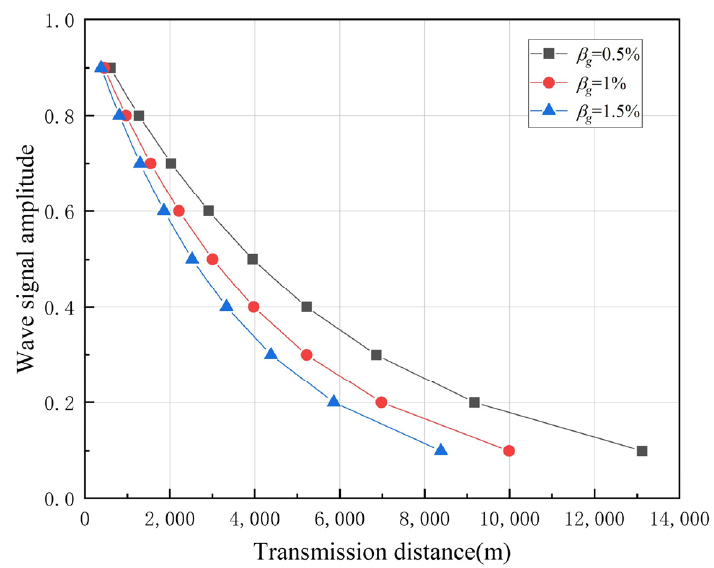
Figure 7. Effect of gas content on wave signal attenuation. Attenuation of the wave amplitude is caused by two frequency-dependent mecha- nisms, fluid-related and scattering. The fluid-related mechanism is caused by the wave- induced frictional movement between fluid and tubular wall, known by wave-induced fluid flow (WIFF) [35]. Scattering, which is an elastic mechanism, is caused by hetero- geneities in media; for instance, the heterogeneity caused by gas content in this case [36]. The gas content causes the two mechanisms since the compressibility of gas stimulates frictional losses and increases the heterogeneity. However, several studies have shown that when the gas content exceeds 5% the effect of gas on attenuation stagnates